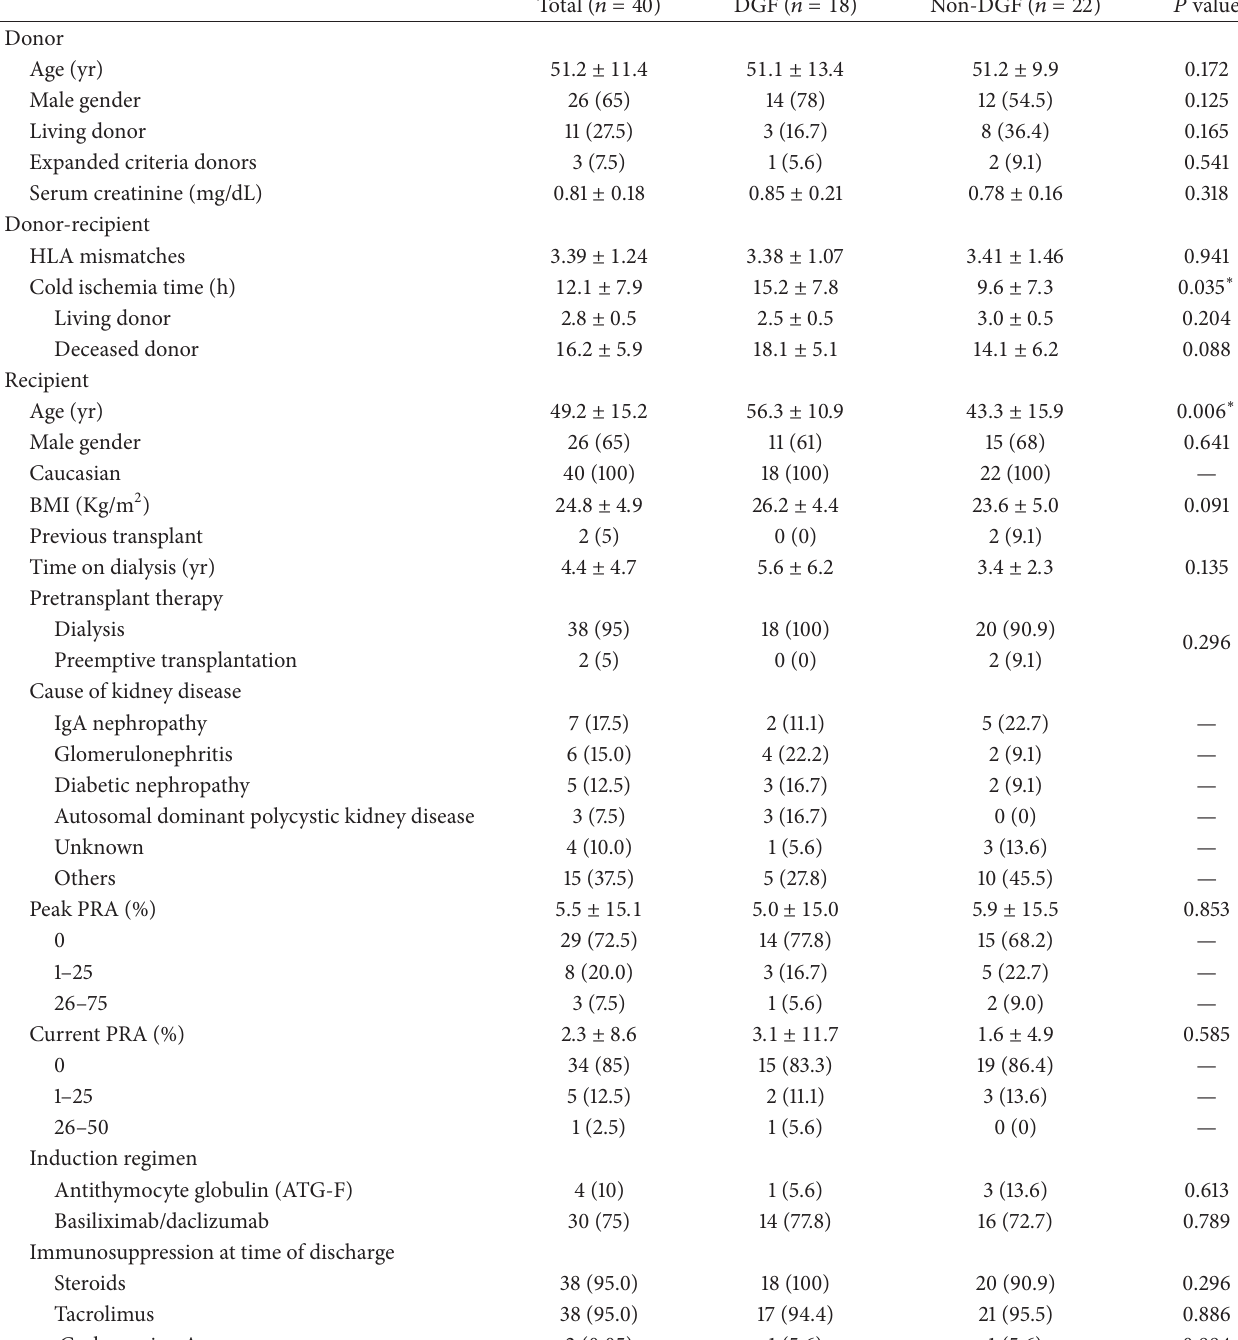
Table 1: Summary of baseline and clinical characteristics in kidney transplant donors and recipients (total sample and categorized by delayed or prompt graft